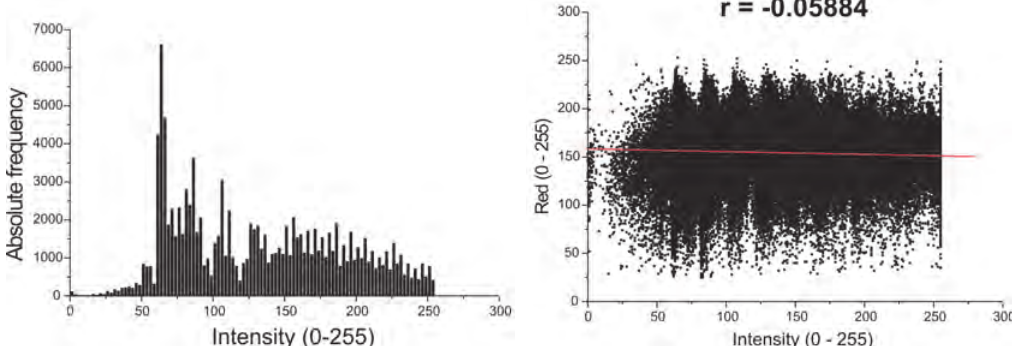
Fig. 7. Statistical distribution of the complete intensity data set extracted from the whole volcanic wall (a), and red channel and Intensity correlation